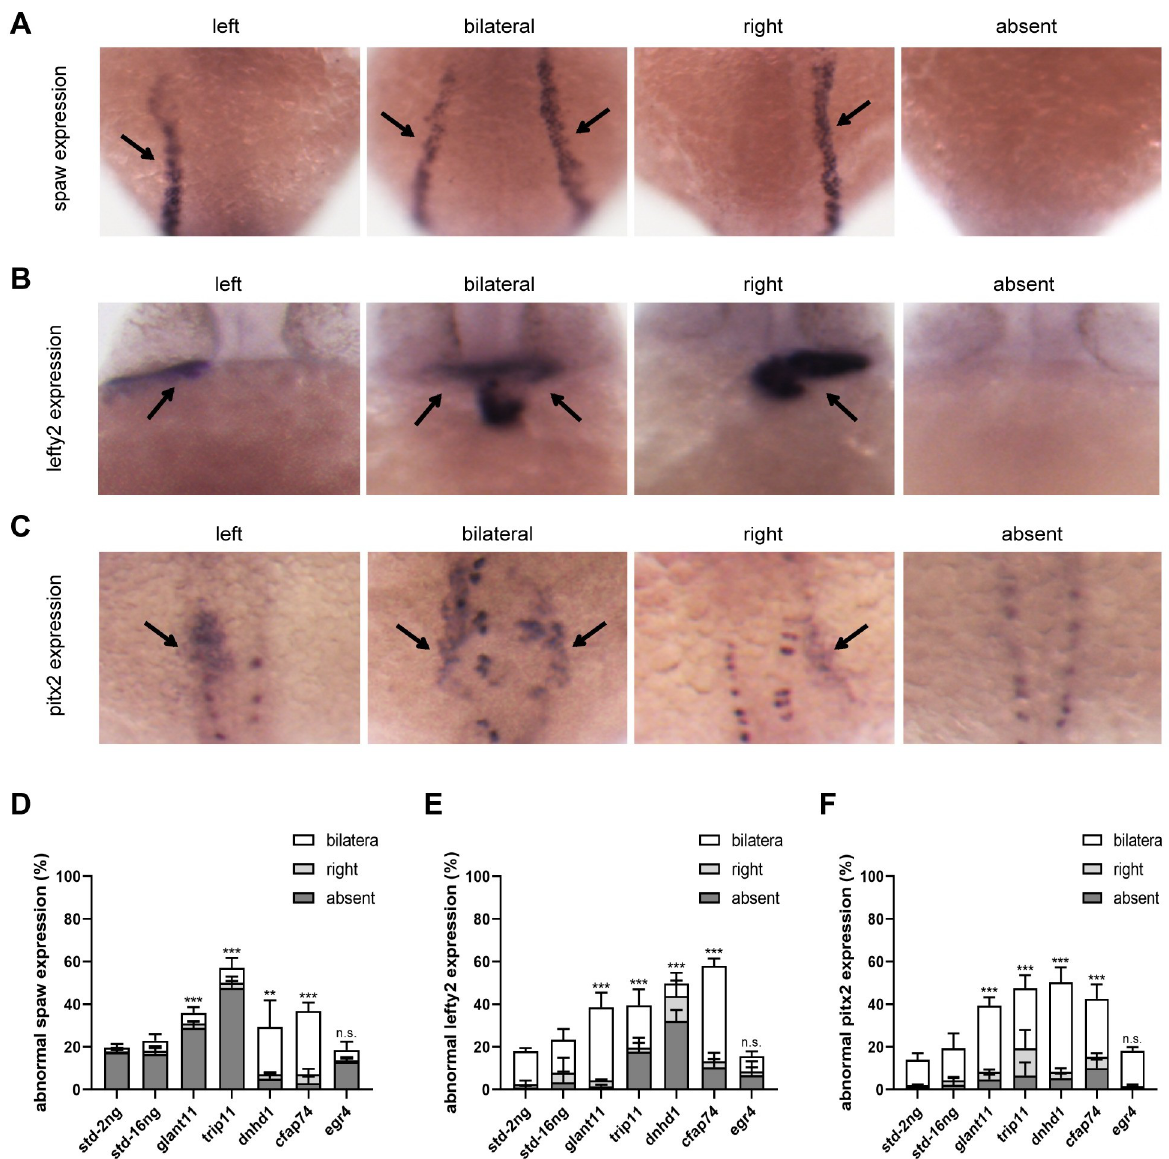
Fig 4. The expression patterns of spaw , lefty2 , and pitx2 at 18–24 hpf. (A, C) the expression of spaw and pitx2 exhibit four patterns in LPM: left (normal), right (abnormal), bilateral (abnormal), or absent (abnormal). (B) The expression of lefty2 shows four patterns in the cardiac field: left (normal), right (abnormal), bilateral (abnormal), or absent (abnormal). (D-F) Summary of spaw , lefty2 , and pitx2 mRNA expression in zebrafish morphants. Embryos are viewed dorsally with anterior to the top. Each experiment was repeated at least 3 times with > 50 embryos examined for each group every time. Chi-squared test (continuity corrected) was used in D, E and F; � P < 0.05, �� P < 0.01, ��� P < 0.001, respectively vs. Std- 16ng ( glant11 , trip11 , dnhd1 , and cfap74 ) or Std-2ng ( egr4